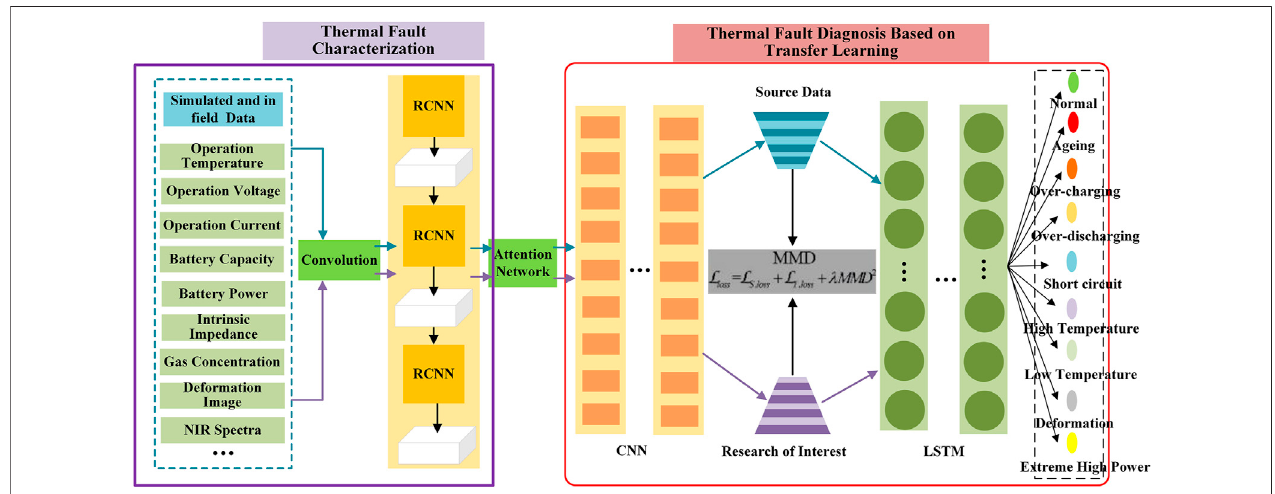
FIGURE 7 | Intelligent fault diagnosis method based on big data